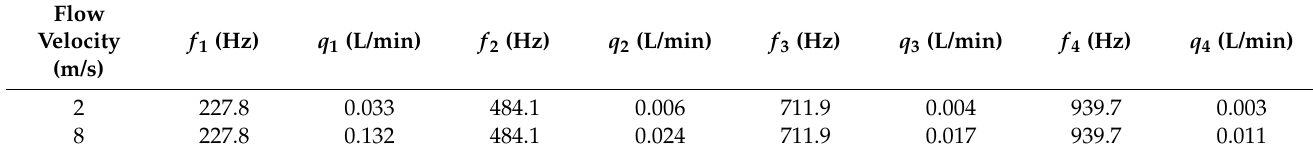
Table 3. Spectrum characteristics of flow pulsation.